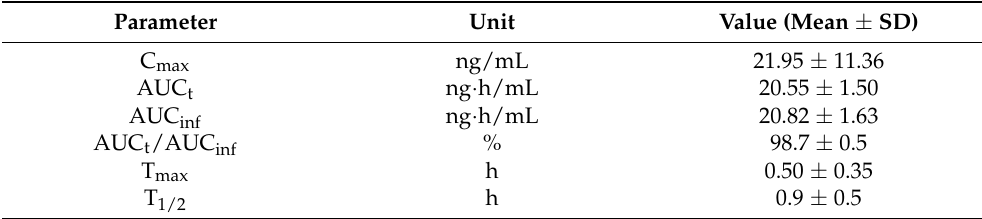
Figure 4. Plasma concentration-time curves for p -Coumaric acid in human plasma after oral administration of BC. Table 2. The main PK parameters of p -Coumaric acid in human plasma after oral administration of BC.